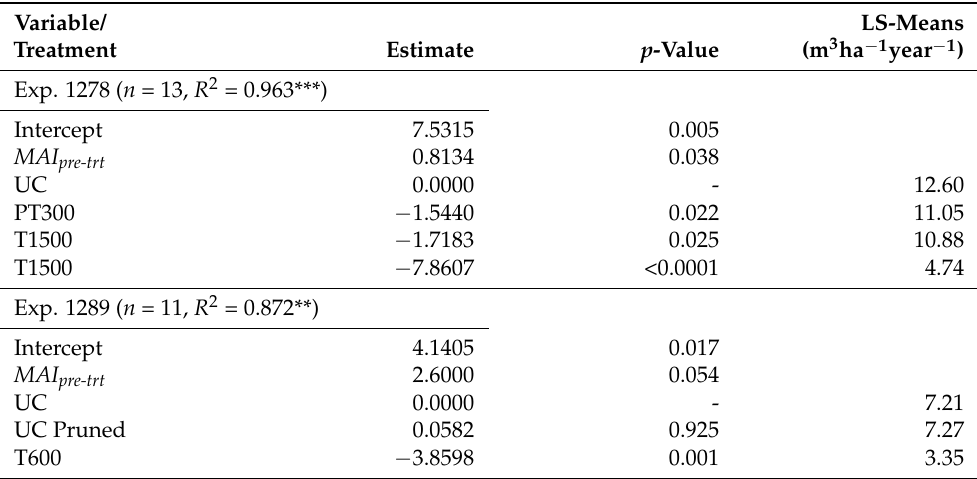
Figure 2. Mean annual stand volume growth ( I V , m 3 ha -1 year -1 ) vs. pre-treatment mean annual vol- ume increment ( MAI pre-trt , m 3 ha -1 year -1 ) depending on treatment. Parameter estimates for the re- gression lines are given in Table 4. Legend for treatments: UC = black, UC-pruned = green, PT300 = yellow, T1500 = blue, T600 = red. Table 4. Parameter and LS-means estimates for the final model of stand volume growth depending on treatment and pre-treatment MAI ( MAI pre-trt , m 3 ha -1 year -1 ). Legend: n = number of observations, R 2 = coefficient of determination.